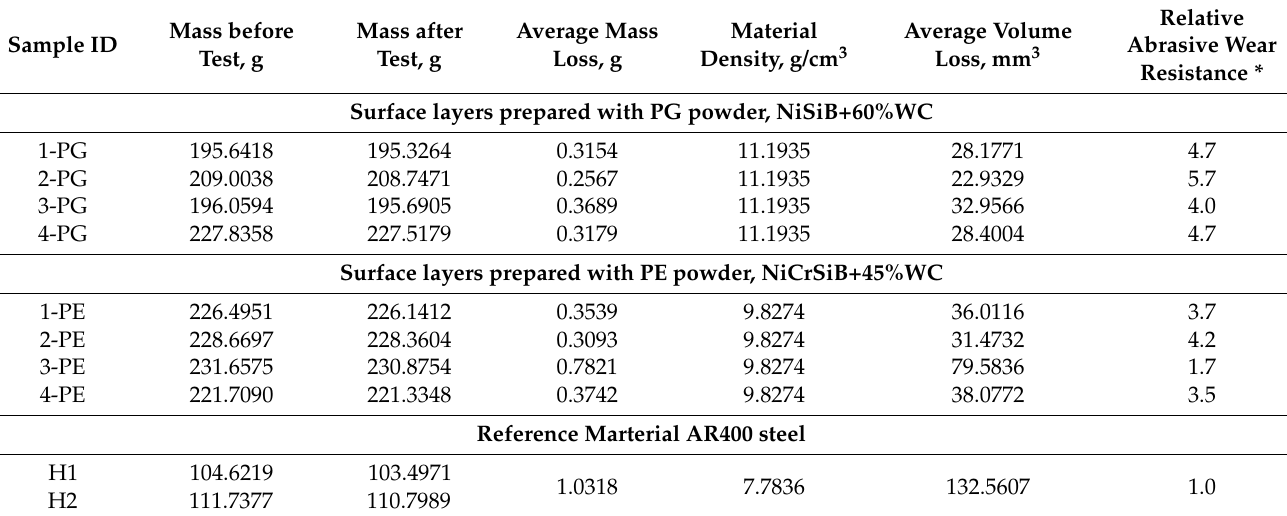
Table 9. Abrasive wear resistance tests results.